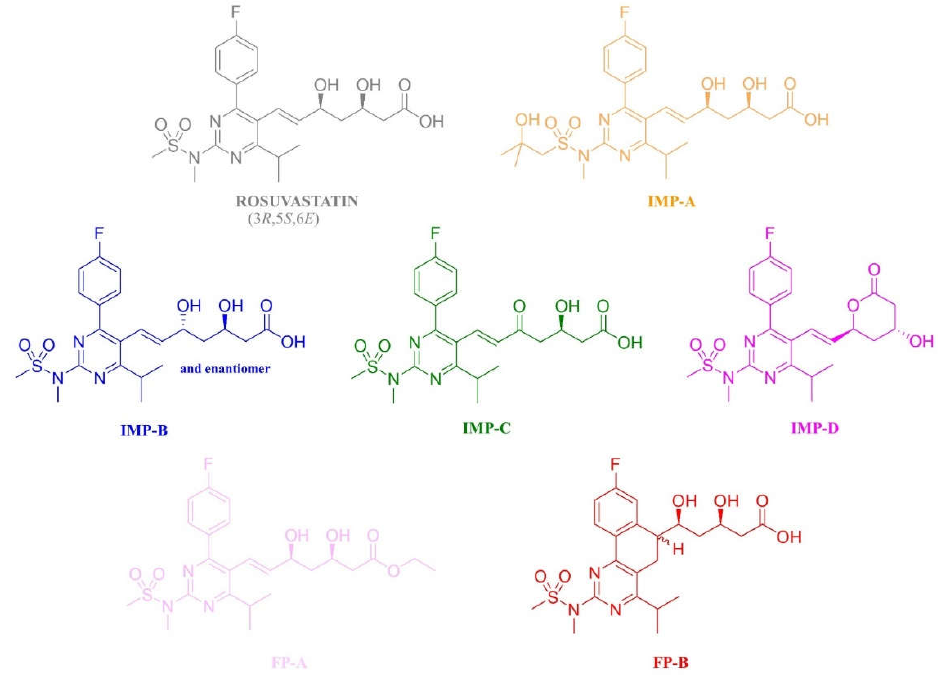
Figure 1. Chemical structures and abbreviations of rosuvastatin and its potential organic impurities listed in the EP monograph for rosuvastatin tablets. IMP-A: impurity A; IMP-B: impurity B; IMP-C: impurity C; IMP-D: impurity D; FP-A: impurity FP-A; FP-1: first eluted diastereomer of the impurity FP-B; FP-2: second eluted diastereomer of the impurity